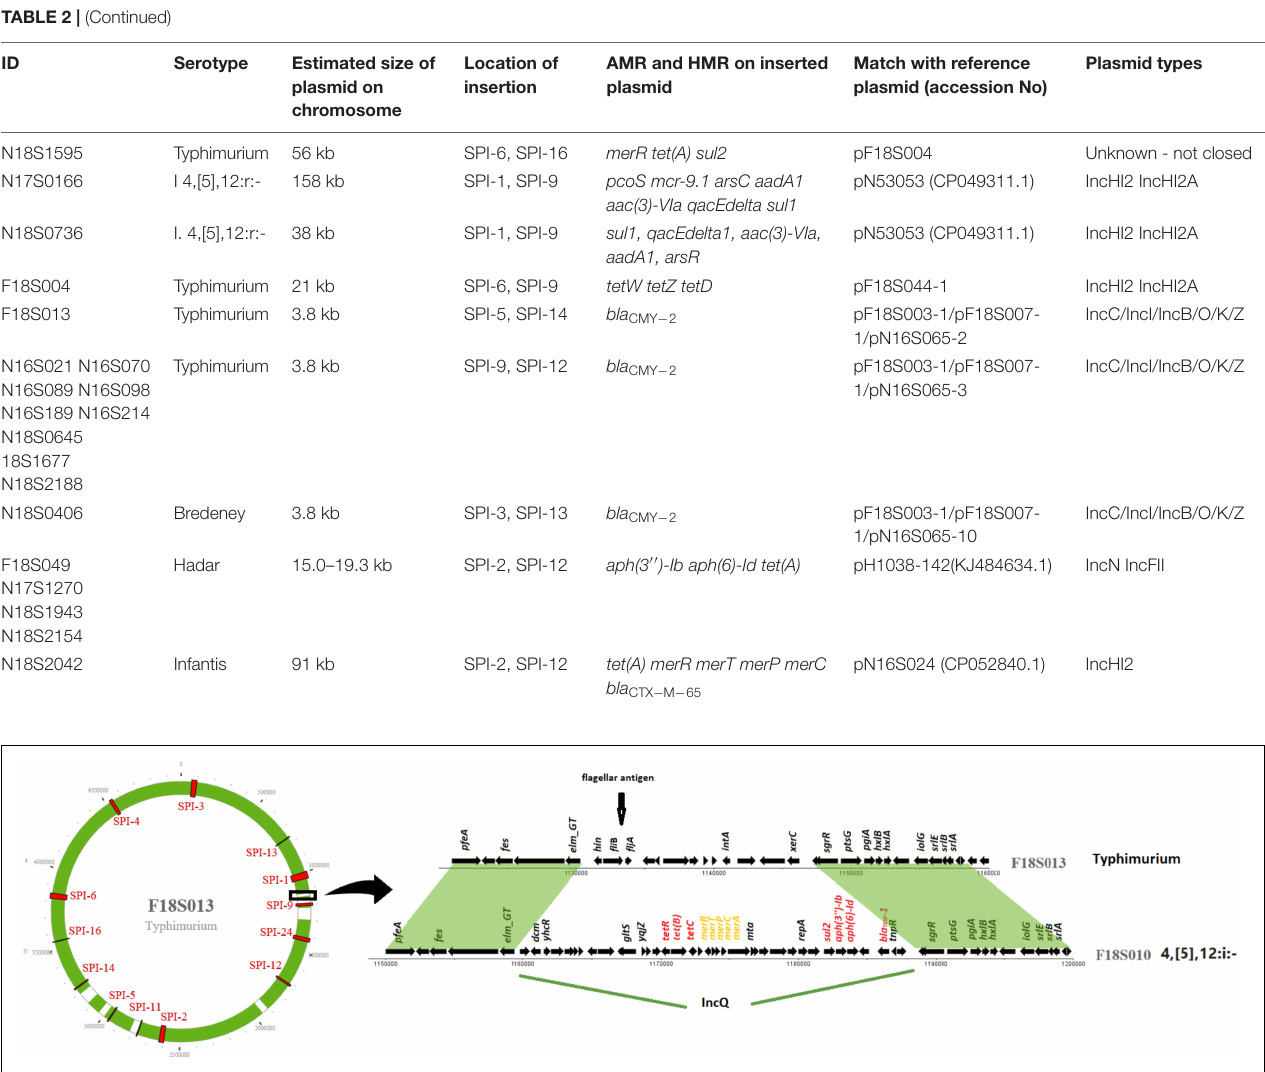
FIGURE 2 | IncQ plasmid integrated into Salmonella I 4,[5],12:i:- chromosome. The circle on the left represents a chromosome structure of a S. Typhimurium strain F18S013 with SPIs (in red) distributed on the chromosome. The green area was the sequence homologous to a Salmonella I 4,[5],12:i:- strain F18S010. The gray area shows differences between the two strains. The detailed comparison of the genomic structure of the two strains on the right is from the area with black box on the chromosome.